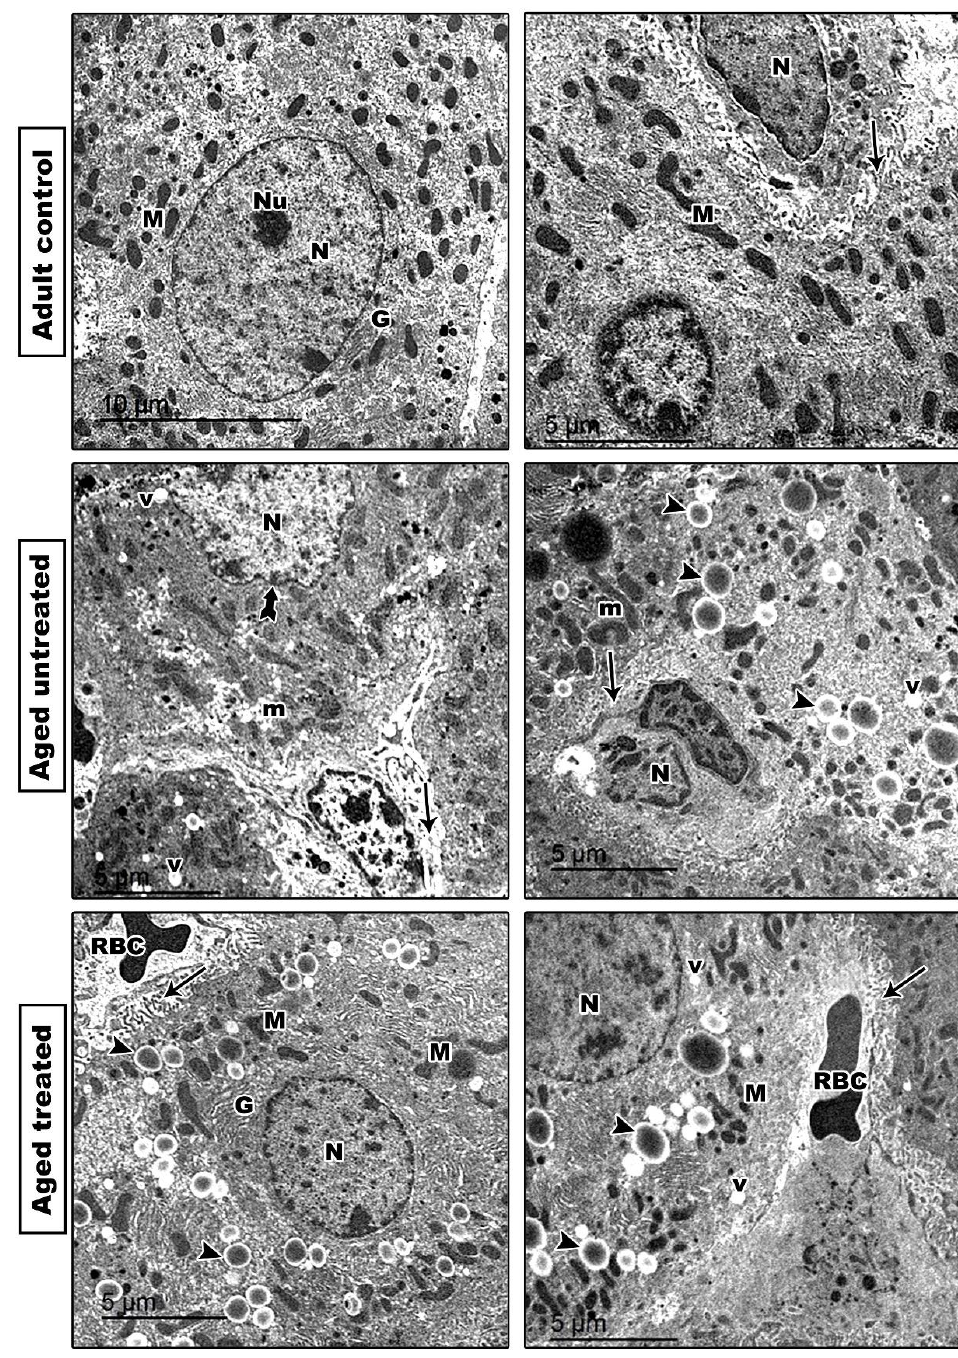
Figure 3. Transmission electron photomicrograph of hepatocytes showing: A1 and A2: Adult control hepatocytes with euchromatic nucleus, prominent Golgi apparatus and numerous elongated mitochondria. Abundant microvilli of hepatocytes are noted in the perisinusoidal space of Kupffer cells are also shown with their irregular dark nuclei. B1 and B2: Aged untreated hepatocytes showing irregular nuclei and rarefied cytoplasm with multiple vacuoles and lipid droplets. Hepatocytes nuclear degenerative changes are noted. Microvilli of hepatocytes are disrupted or lost. C1 and C2: VK2-treated aged group showing hepatocyte with regular nuclei, restored microvilli of hepatocytes and elongated normal mitochondria. N: nucleus, Tailed arrow: irregular nucleus, M: normal mitochondria, m: degenerated mitochondria, V: Cytoplasmic vacuoles, Arrows: microvilli, G: Golgi complex and Head arrows: lipid droplets.